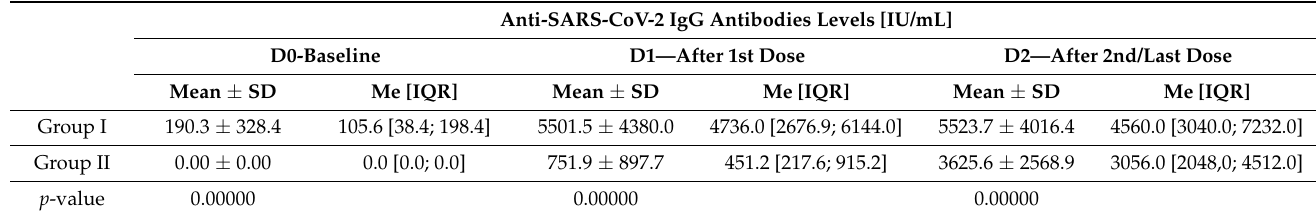
Table 3. Anti-SARS-CoV-2 IgG antibody levels at each stage of the